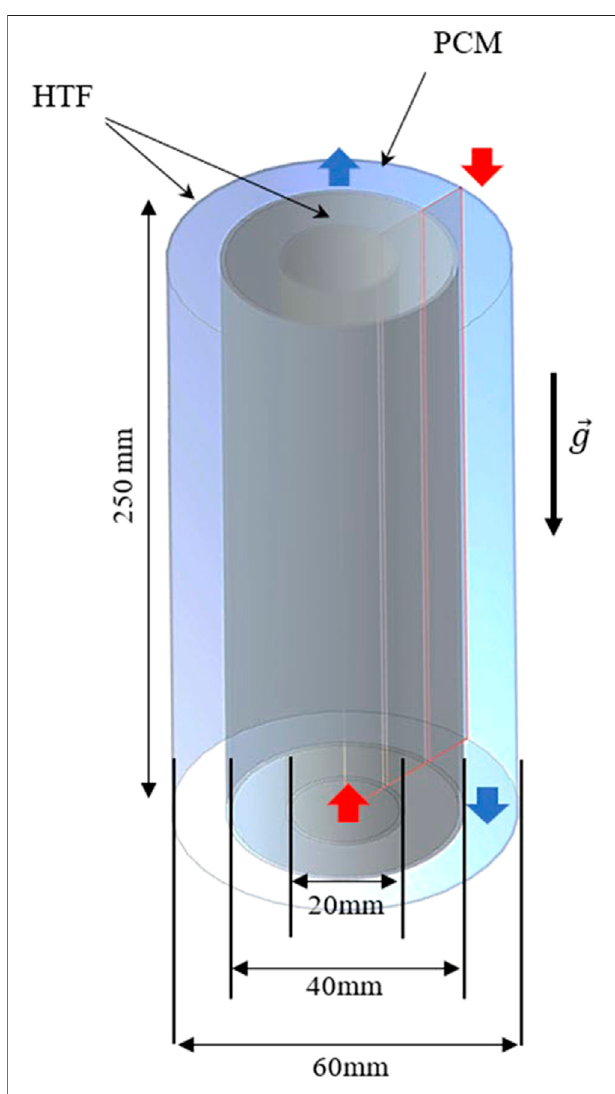
FIGURE 2 | The triple-tube heat exchanger along with boundary conditions and dimensions for the No-Fin case.